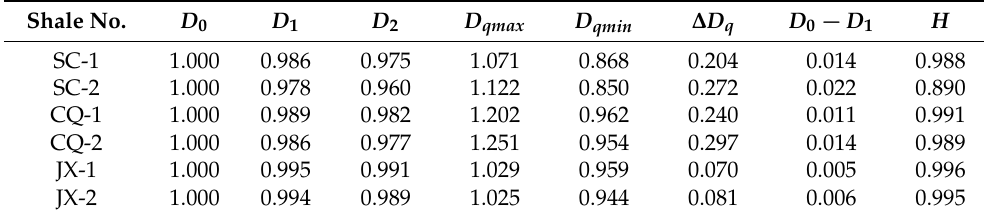
Table 2. Characteristic parameters from generalized fractal spectra of organic shale pores. Shale No.